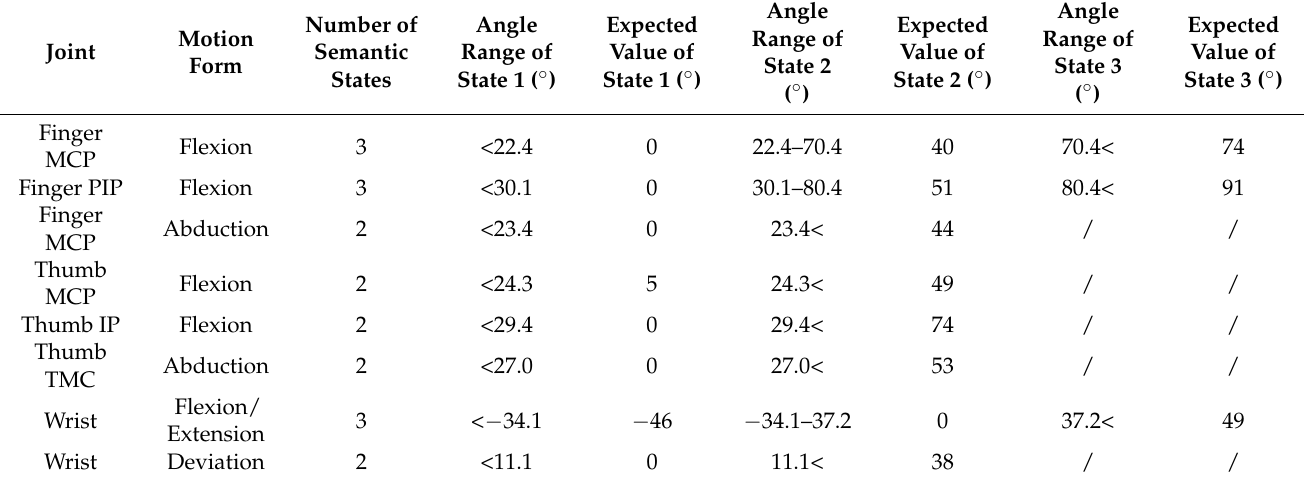
Table 6. Semantic state classification results of each hand motion primitive unit for Leap Motion digital